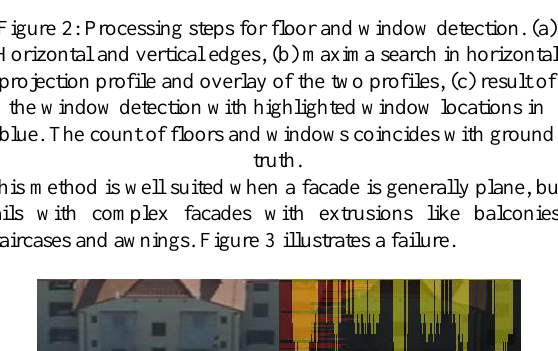
Figure 5: Correlation coefficients calculated for 4 different planes visualized as binary images (white areas have the largest correlation